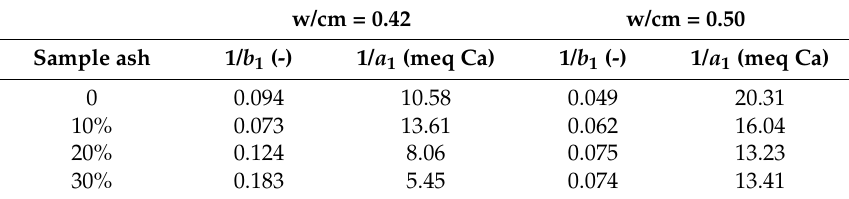
Table 8. Parameters fitting Equation 1 to describe the specimen calcium ion release.